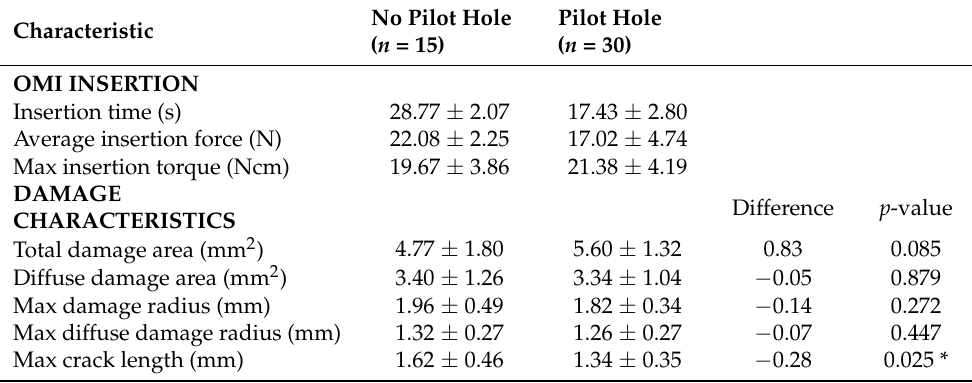
Table 1. Characteristics of bone block specimens of combined thicknesses with and without a pilot hole drilled prior to insertion of the orthodontic miniscrew implant (OMI).